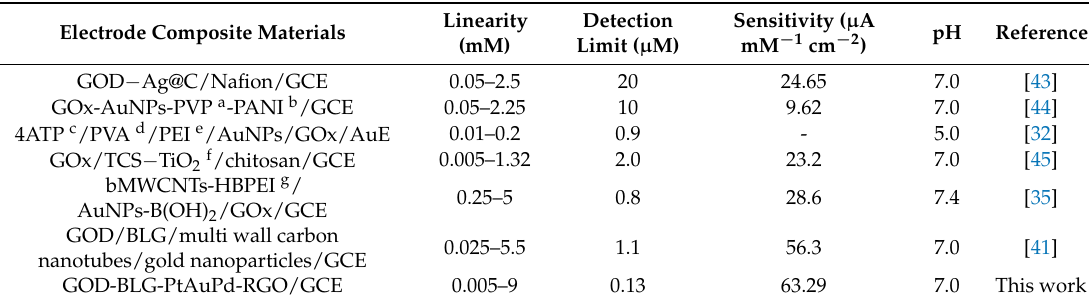
Table 1. Characteristics of various reported glucose